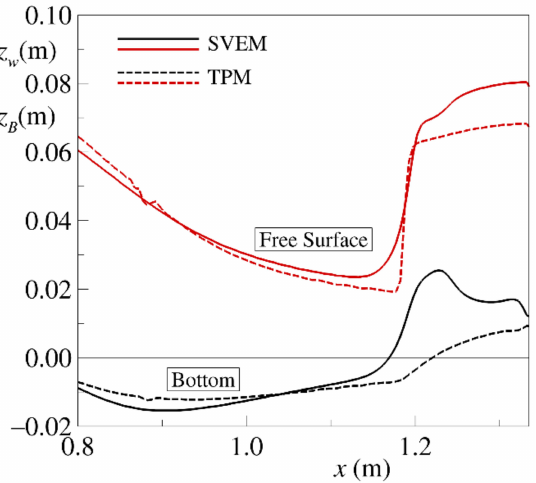
Figure 10. Spatial free surface (z w ) and bottom (z B ) evolution at t = 1.5 s and y = 0.6 m for PVC particles d = 5 × 10 − 4 m. SVEM Vs.